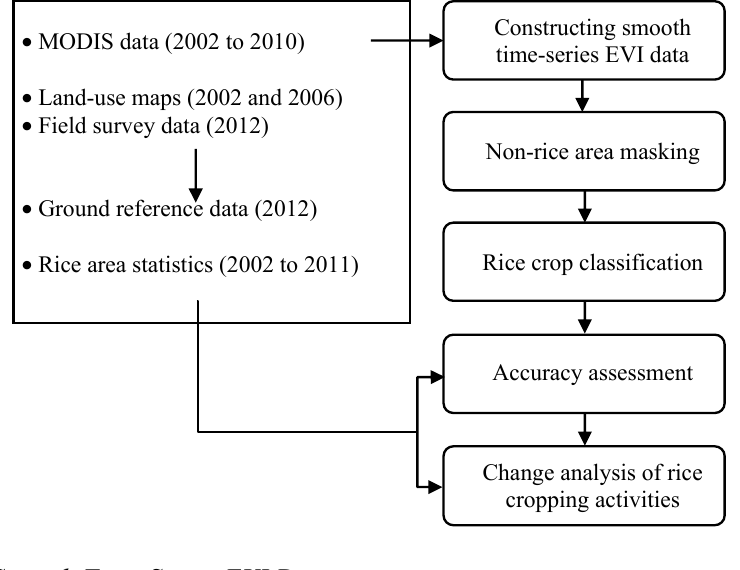
Figure 2. Flowchart of the methodology showing steps of data processing used in this study. EVI, enhanced vegetation index. MODIS, Moderate Resolution Imaging